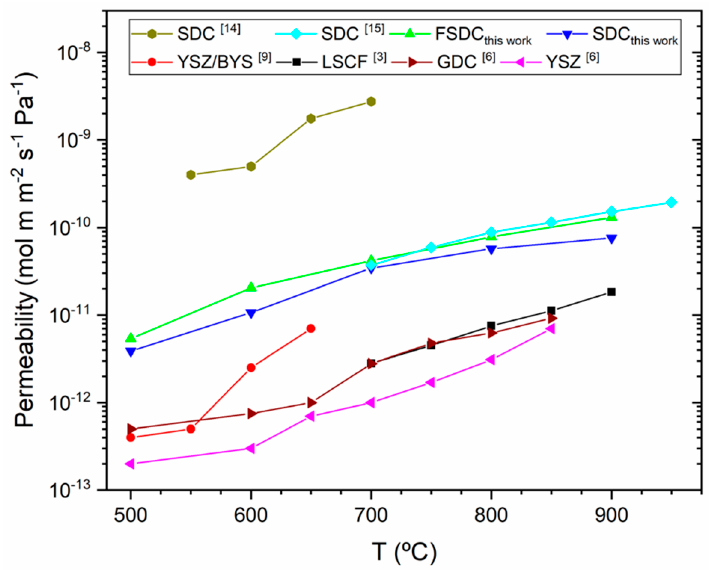
Figure 8. Comparison chart displaying experimental permeability data of several DP membrane systems from literature and this study.